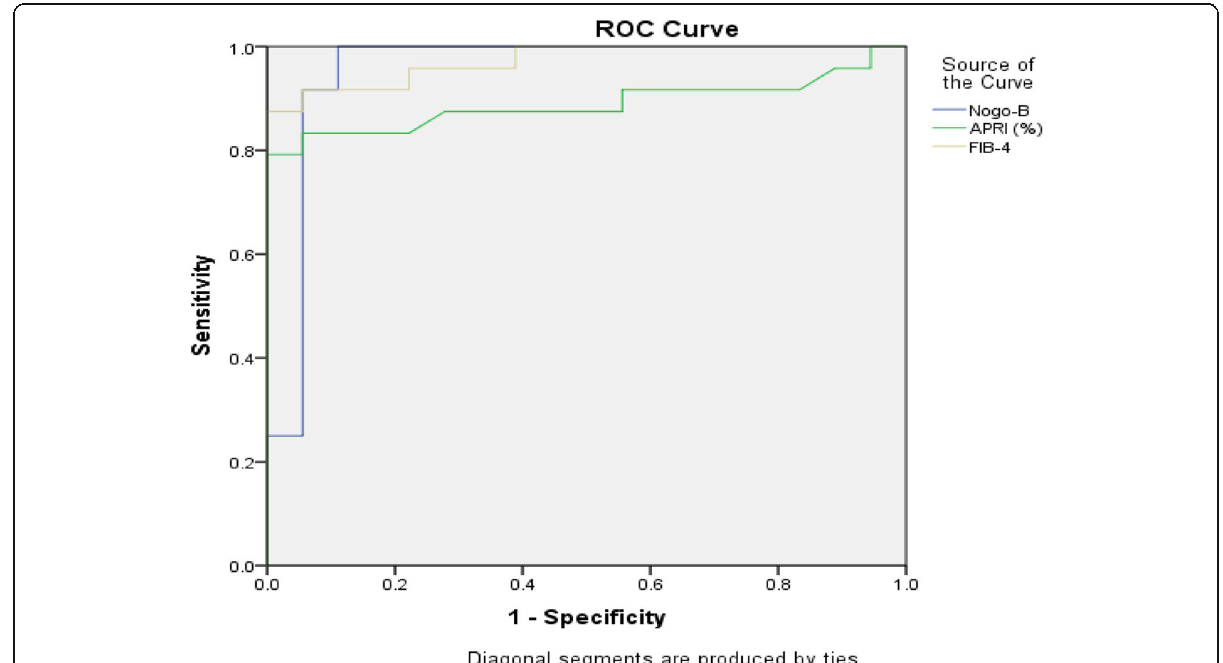
Fig. 3 Roc curve shows the sensitivity and specificity of serum Nogo-B, APRI, and FIB-4 in the child A